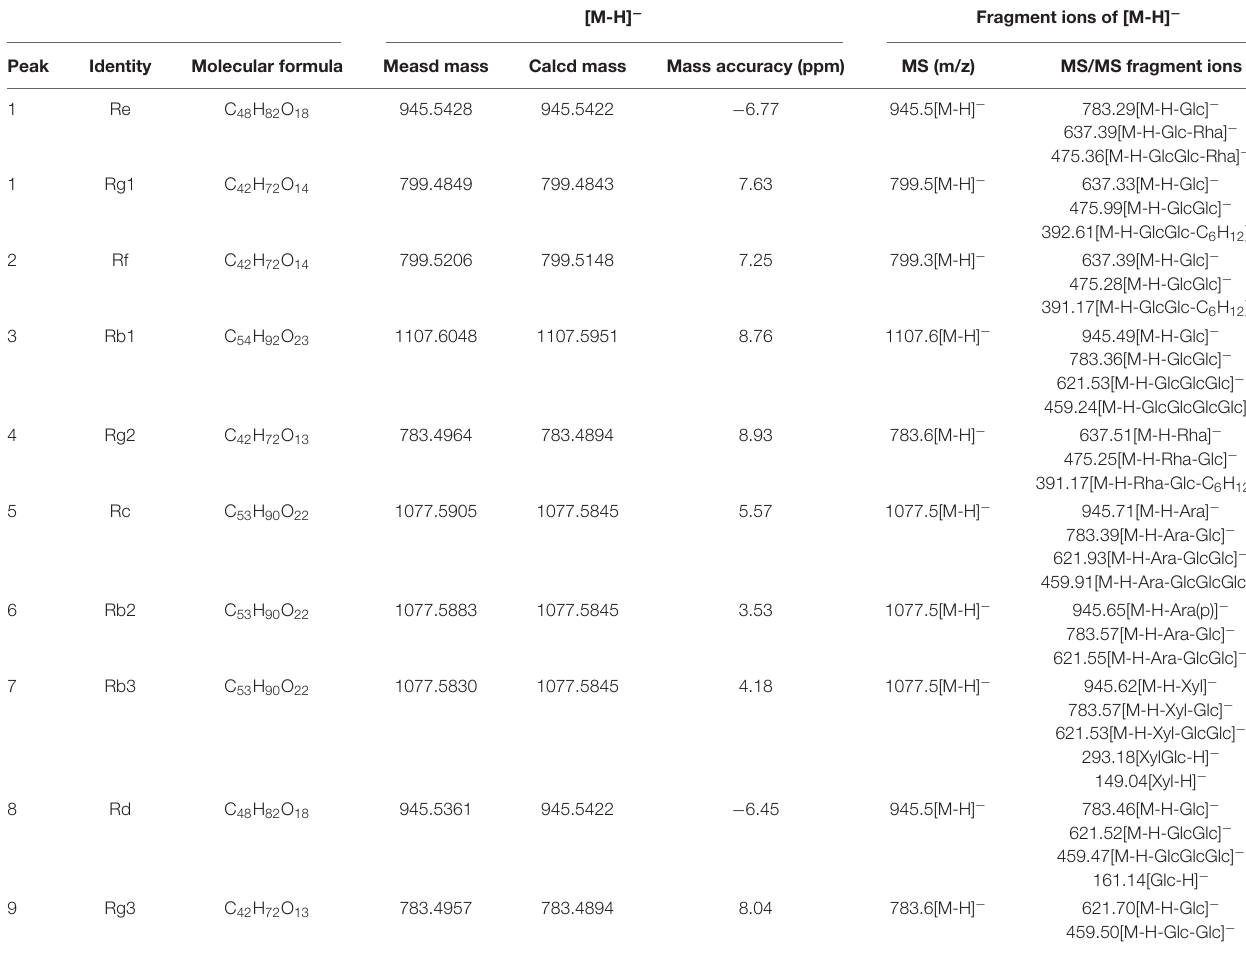
TABLE 1 | Compounds identified from red ginseng